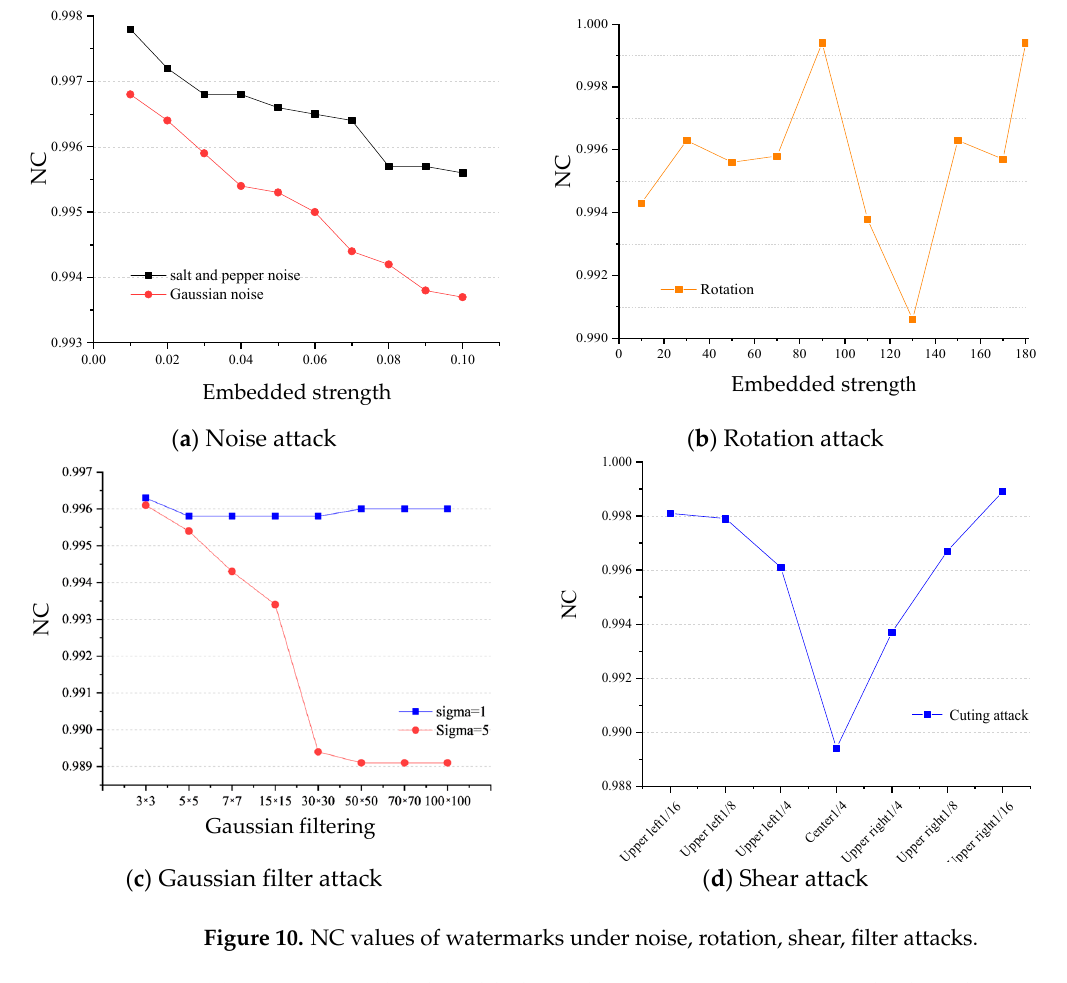
Figure 10. NC values of watermarks under noise, rotation, shear, filter attacks.